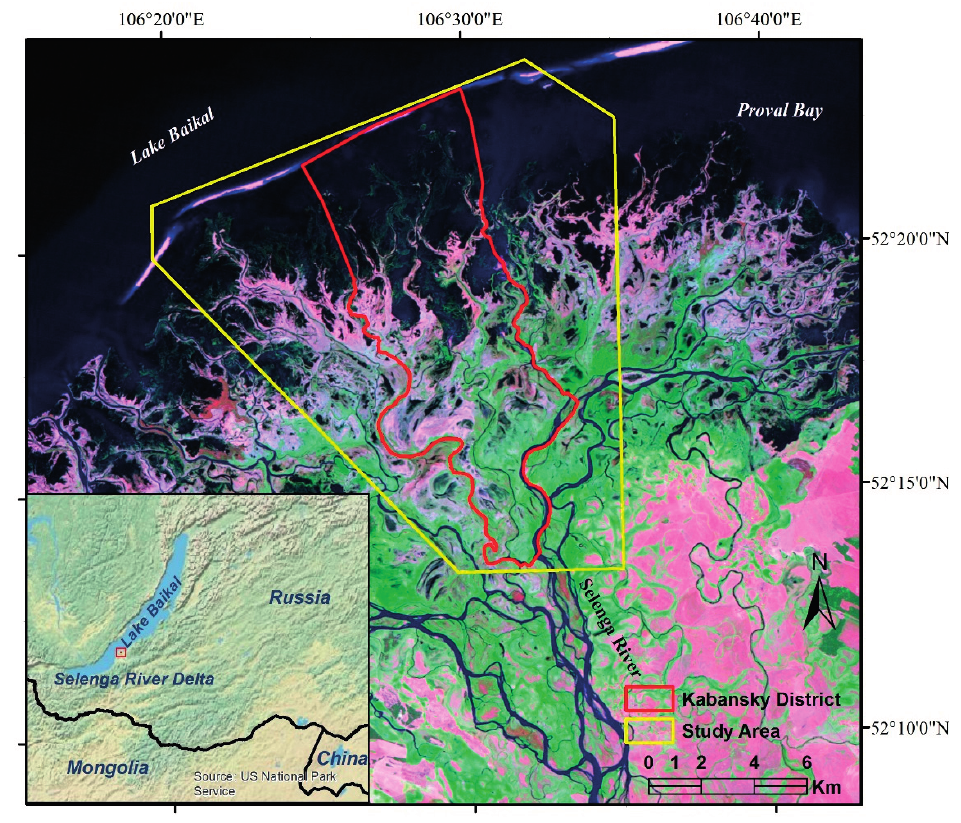
Figure 1. Location of Selenga River Delta study area in the Kabansky District of the Baikalsky Nature Preserve, shown with bands 7, 4, and 3 from the WorldView-2 (WV2) imagery as